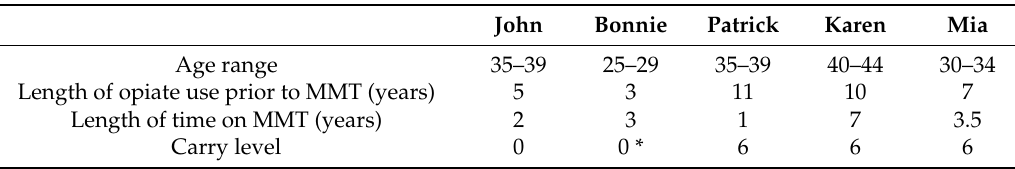
Table 1. Participant